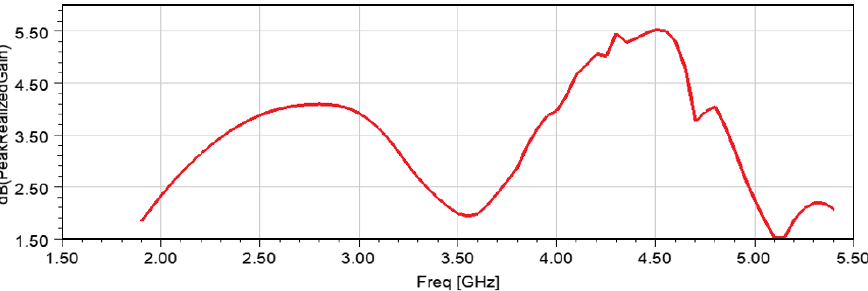
Figure 14. Peak realized gain of the proposed antenna 2.